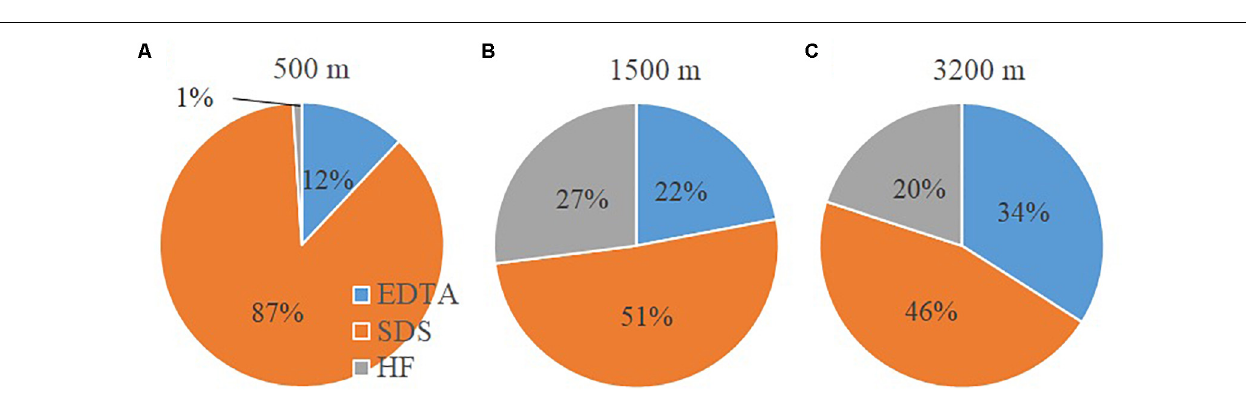
FIGURE 3 | Intensity percentages of the three sequential fractions determined by electrospray ionization (ESI) Fourier-transform ion cyclotron resonance mass spectrometry (FTICRMS) in the settling particles: (A) 500 m; (B) 1500 m; (C) 3200 m.